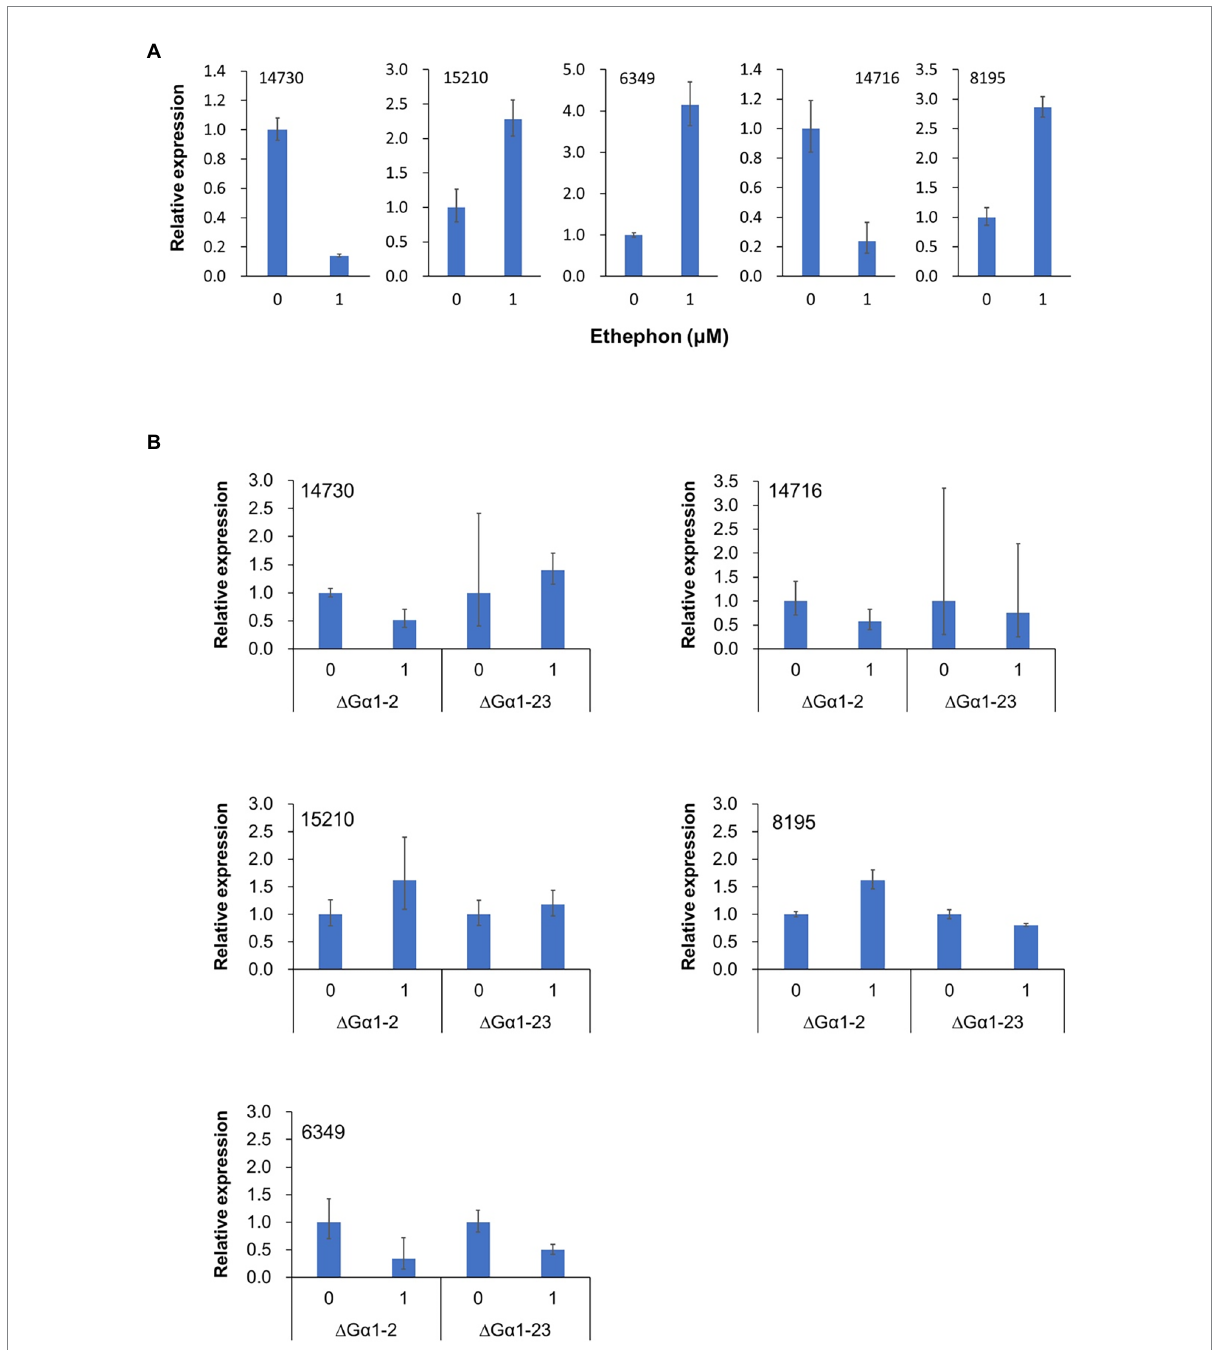
FIGURE 8 Relative expression of five genes (14,730-hydrophobin, 15,210-cutinase, 14,716-major facilitator family, 8,195-pectate lyase, and 6,349-amino acid permease) in Colletotrichum asianum TYC-2 (A) and G 𝛼 1 mutants ( ∆ G 𝛼 1–2, ∆ G 𝛼 1–23) (B) at 3 h after treatment with 0 or 1 μ M ethephon. Relative expression was determined using actin gene as internal control and calculated with comparative ΔΔ Ct method by comparing to water